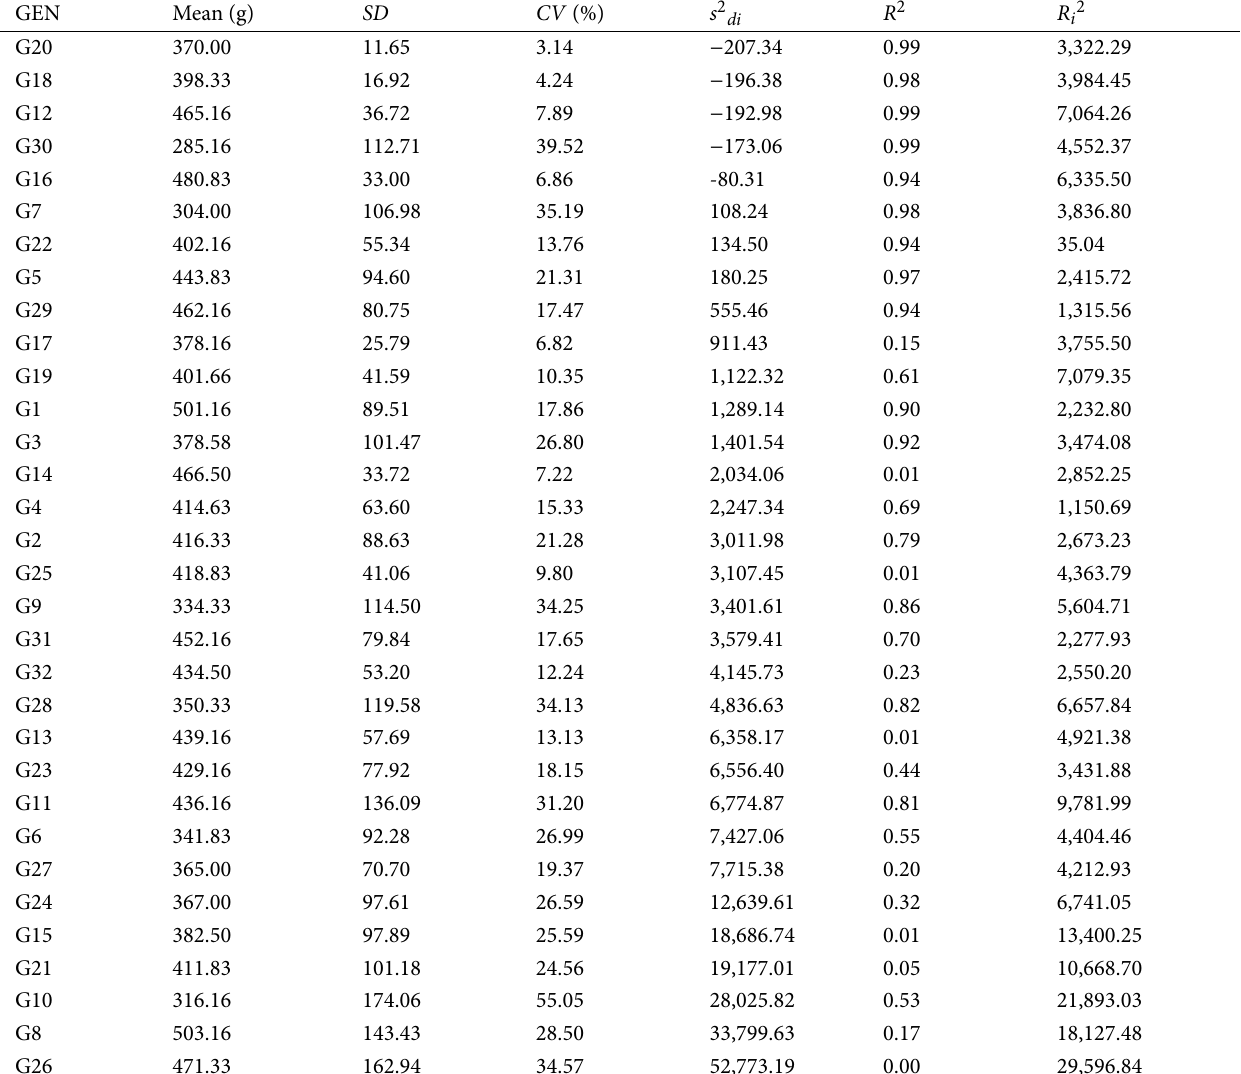
Table 6 Analysis of stability based on measurements of regression ( b i ) and variability ( s 2 di )